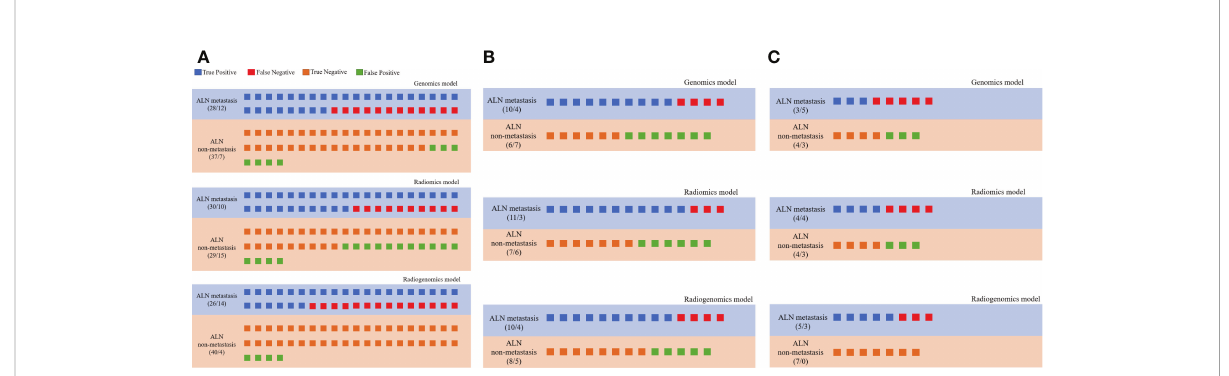
FIGURE 6 Prediction pro fi les of the three models. All individual participants were identi fi ed as “ LNM ” or “ non-LNM ” , and recognized as true positive (blue), false negative (red), true negative (orange) and false positive (green) according to their true labels of LNM in all groups. (A) Prediction pro fi les of the training group; (B) Prediction pro fi les of the testing group; (C) Prediction pro fi les of the external validation groups.